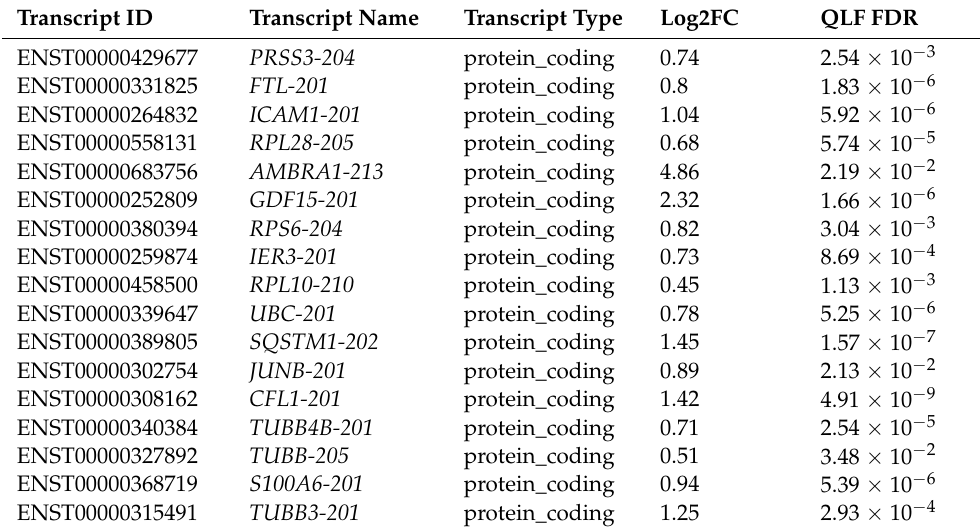
Table 5. List of statistically significant DE transcripts associated with the development of resistance to docetaxel treatment on PC3